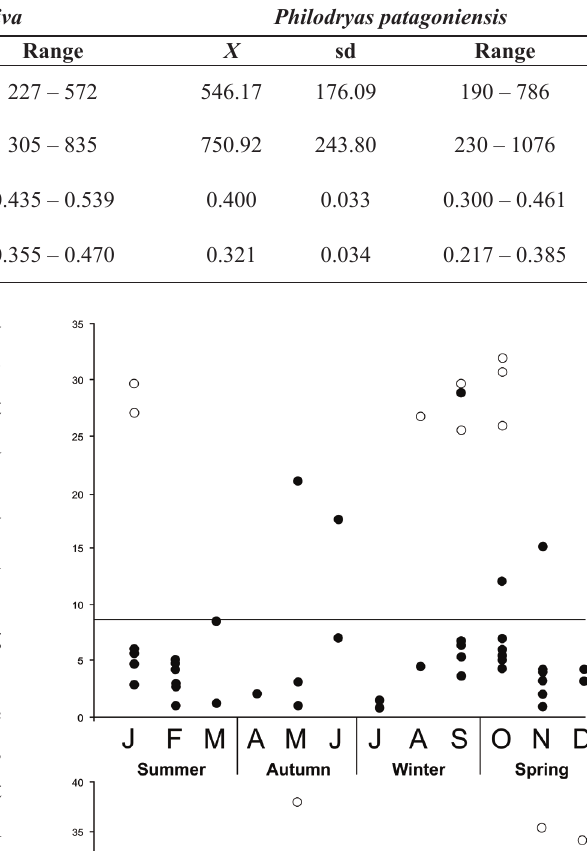
Values of means ( X ), standard deviation (sd) and range of the variables analyzed in Philodryas aestiva and Philodryas patagoniensis from the Brazilian coastal Pampa, Rio Grande do Sul state (SVL = snout-vent length; TL/SVL = tail proportion in relation to SVL).